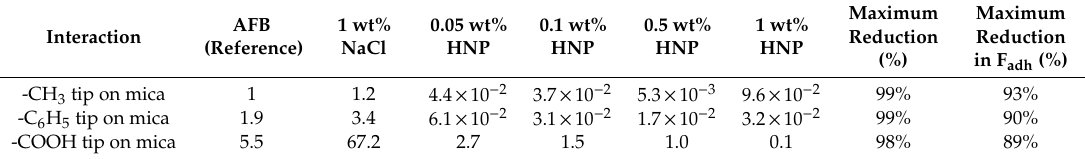
Table 4. Work of adhesion (aJ) in the presence of -CH 3 and -C 6 H 5 coated tips on mica immersed in brine at high and low salinity conditions.